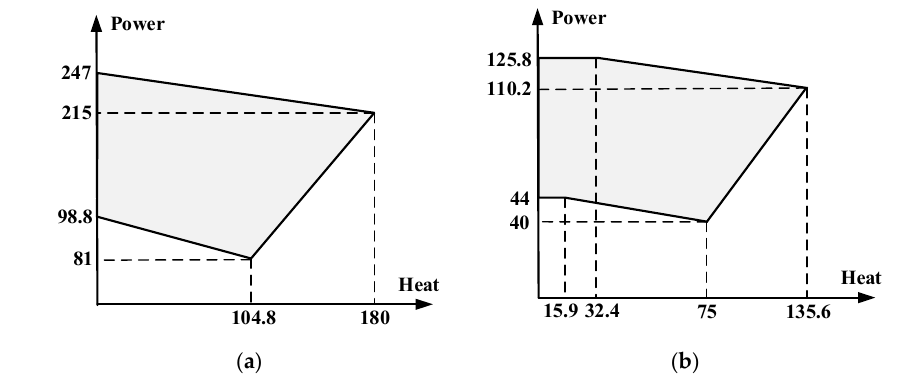
Figure 5. FOR of ( a ) CHP unit 1 and ( b ) CHP unit 2.